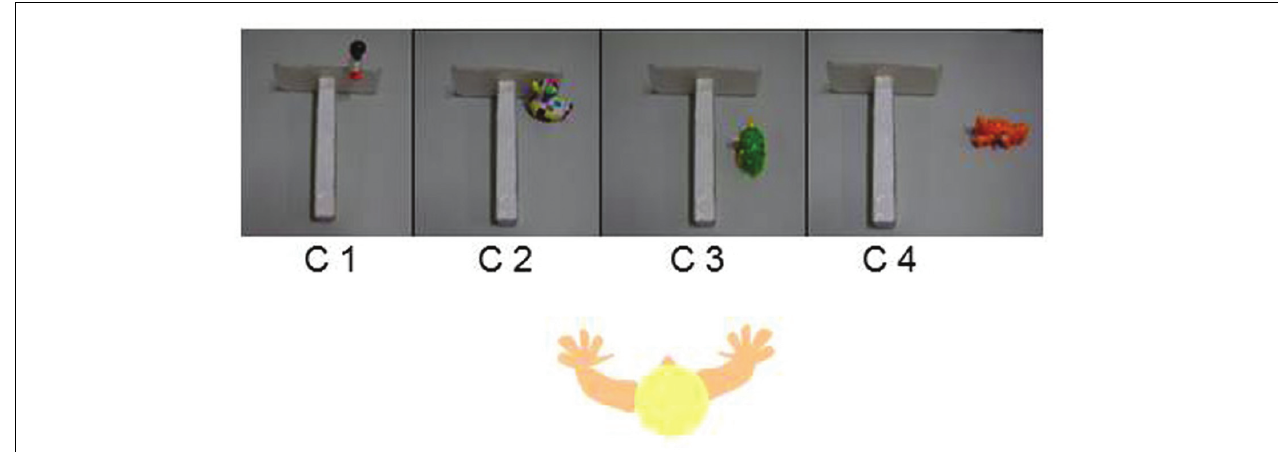
FIGURE 1 | Tool use conditions (C5, where the tool is handled to the child) is not shown.